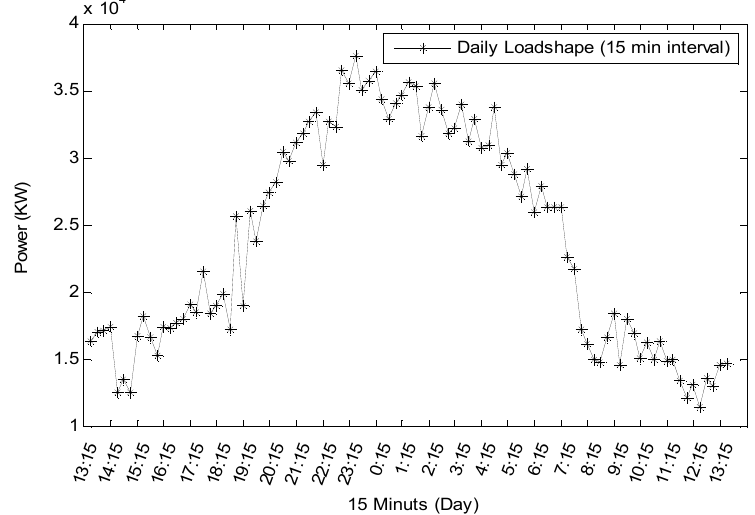
Figure 3. Daily load shape of a commercial area in Malaysia.